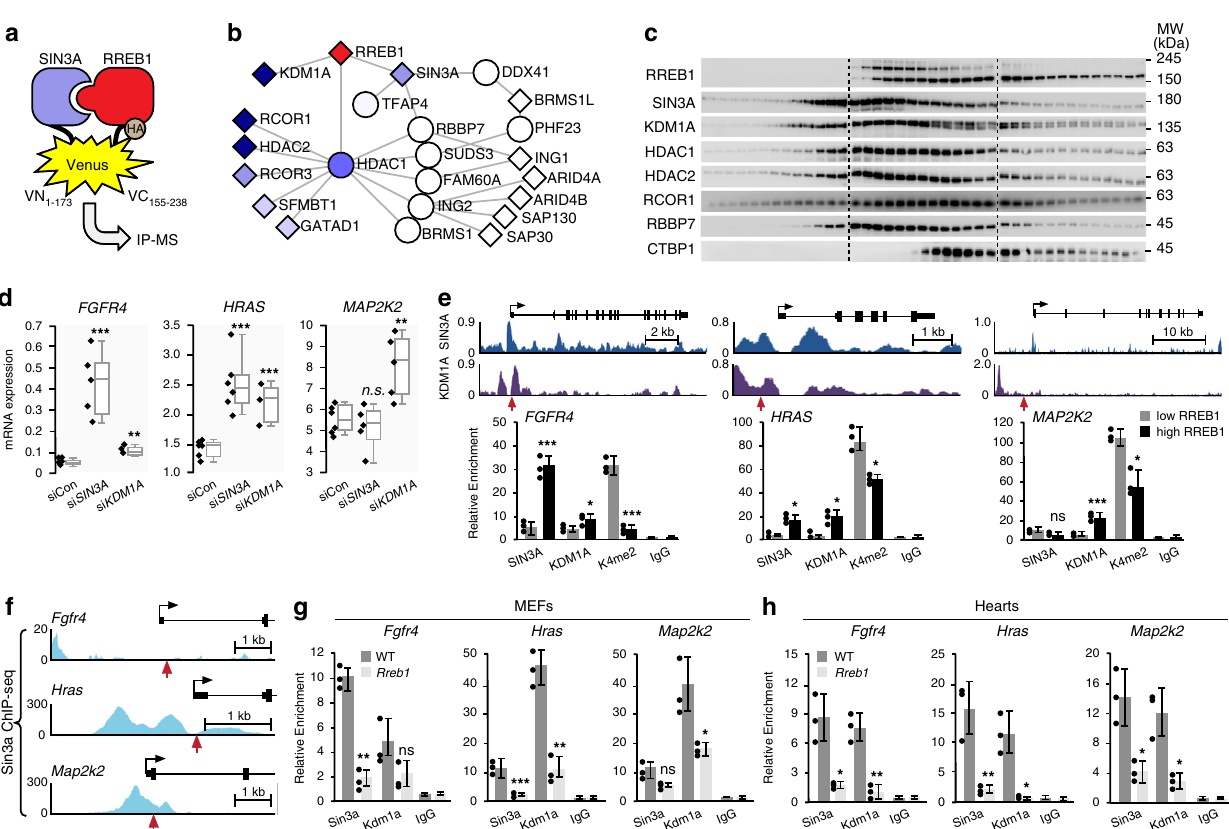
Fig. 6 RREB1 recruits a SIN3A-KDM1A silencing complex to target promoters. a Schematic of the protocol for isolation of the RREB1-SIN3A binary complex. RREB1-VC and SIN3-VN interaction reconstitute Venus (VC + VN) as the bait for IP-MS. b BioPlex2.0 analysis of the RREB1-SIN3A complex components identi fi ed by MS. Bait proteins are represented by a circle and prey proteins with a square. Proteins also identi fi ed in the RREB1-BioID are color coded based on SpecSum counts described previously. c Western blot analysis of protein fractions isolated by glycerol gradient (60 – 10%) ultracentrifugation. Blots were probed with the indicated antibodies for endogenously expressed RREB1 complex components. Dashed lines indicate different membranes ( n = 3). d Expression of the indicated mRNAs in HEK293 cells expressing control siRNA (siCon) or siRNAs targeting SIN3A or KDM1A ( n = 6). Box plots indicate the IQR of the data and the central line shows the median. e ChIP analysis of RREB1-SIN3A complex binding at the indicated promoter regions. Upper panels show the gene track view of SIN3A ChIP-seq (ENCODE, CistromeDB 63655, MCF-7 cells) and KDM1A ChIP-seq (ENCODE, CistromeDB 64823, K562 cells) at the indicated loci. Gene bodies are shown above the track sets for orientation. Red arrows point to the RRE. Lower panels show SIN3A, KDM1A and H3K4me2 ChIP-qPCR in HEK293 cells with a tet-inducible RREB1 transgene treated with DMSO (low RREB1) or tetracycline (high RREB1) ( n = 3, error bars presented as mean values ± SD). f Gene track view of Sin3a ChIP-seq (ENCODE, Stanford/Yale TFBS, MEL cells) at the murine Fgfr4 , Hras , and Map2k2 proximal promoters. Red arrows point to the putative murine Rreb1 binding elements. g ChIP analysis of Sin3a and Kdm1a at the indicated promoters in WT and Rreb1 + / − MEFs and h WT and Rreb1 + / − 6 month hearts ( n = 3; * p < 0.01, ** p < 0.001, *** p < 0.0001 two-tailed student ’ s t -test, error bars presented as mean values± SD). Source data are provided as a Source Data fi